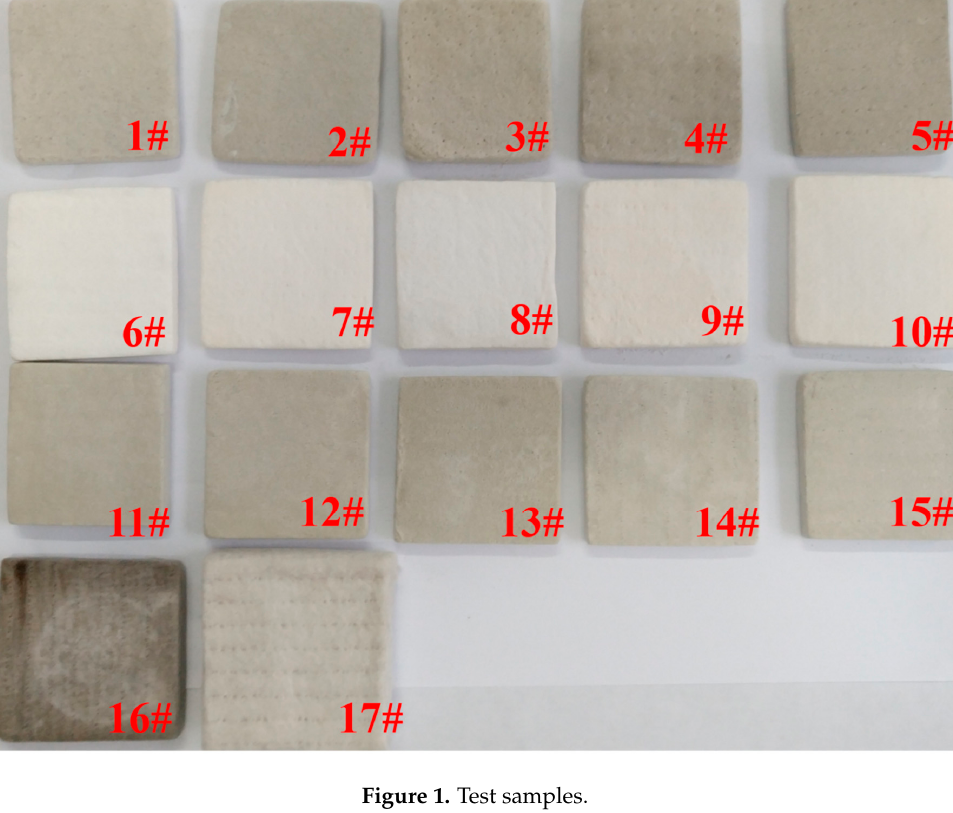
Figure 1. Test samples.